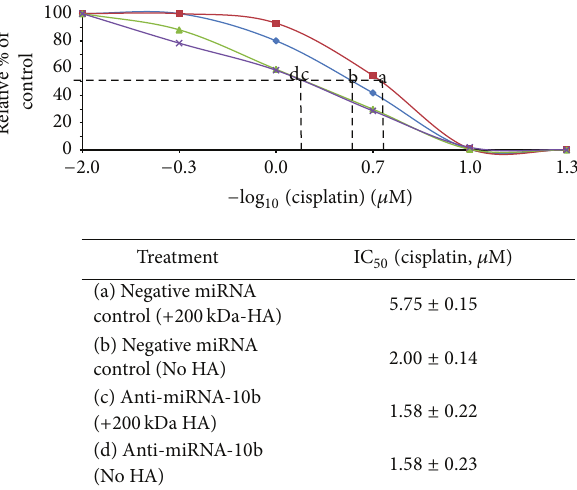
Figure 7: Effects of anti-miR-10b on cisplatin-induced cell growth inhibition in CD 44 v 3 high ALDH 1 high cells following 200 kDa-HA treatment. Effects of cisplatin-induced cell growth inhibition in CD 44 v 3 high ALDH 1 high cells transfected with negative miRNA con- trol plus 200 kDa-HA addition (a) or with no HA addition (b) or transfected with anti-miR-10b inhibitor plus 200 kDa HA addi- tion (c) or with no HA addition (d) for 7 days. Tumor cell growth inhibition (IC 50 ) is designated as “the 𝜇 M concentration of chemotherapeutic drug (e.g., cisplatin treatment) that causes 50% inhibition of tumor cell growth” using CellTiter-Glo Luminescent Cell Viability Assay as described in the Section 2. IC 50 values are presented as the means ± standard